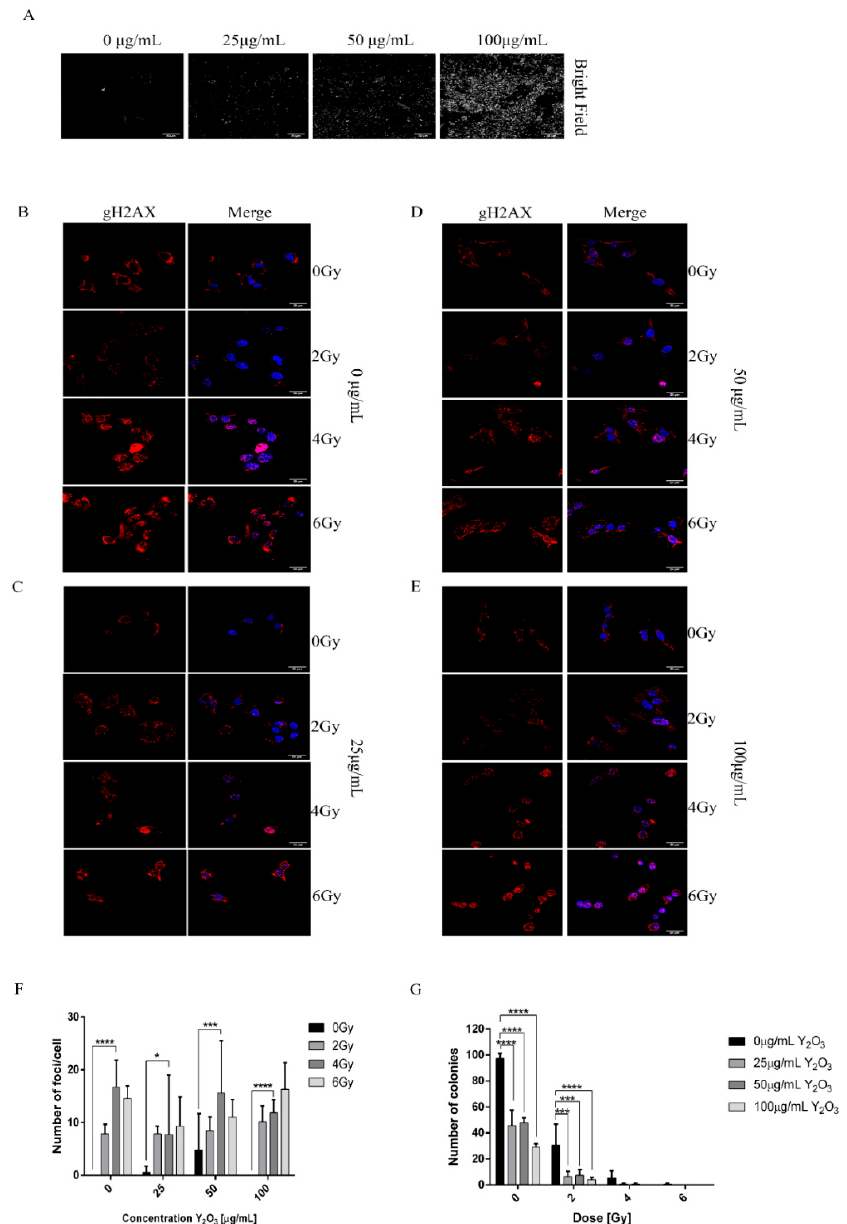
Figure 5. DNA damage induced by X-ray radiation. ( A ) Bright field image depicting the uptake of different concentrations of NPs ( B – E ) A375 cells treated with different concentrations of NPs and irradiated with 0, 2, 4, 6 Gy and stained for γ -H2AX. ( F ) Quantification of number of foci/cell using ImageJ software. ( G ) Clonogenic assay of samples treated with 0, 25, 50, 100 µg/mL Y 2 O 3 and exposed to 0, 2, 4, 6 Gy doses of radiation (* p < 0.05, *** p < 0.005, **** p < 0.0005). The scale bars in Figs ( A – E ) are of 20 µ